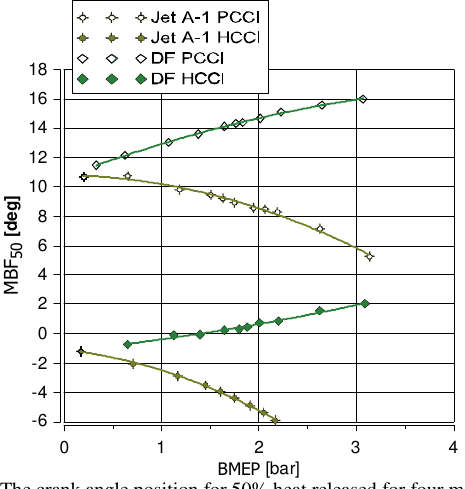
Fig. 13. The crank angle position for 50% heat released for four modes of